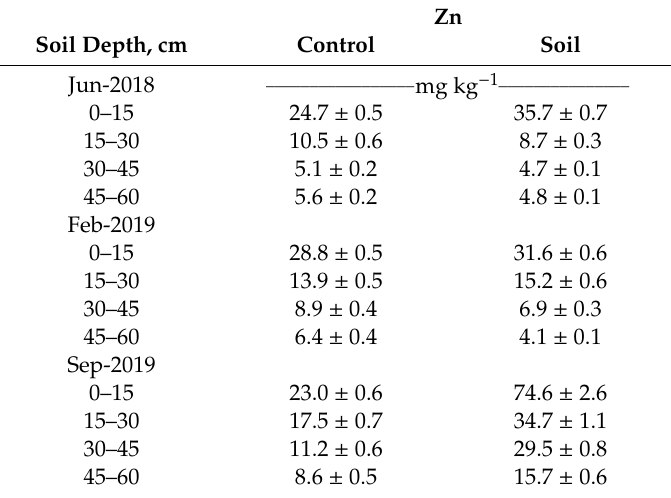
Table 2. Soil Zn distribution in the 0–15, 15–30, 30–45, and 45–60 cm sampling depths on 3 sampling dates. ± are standard errors (n =